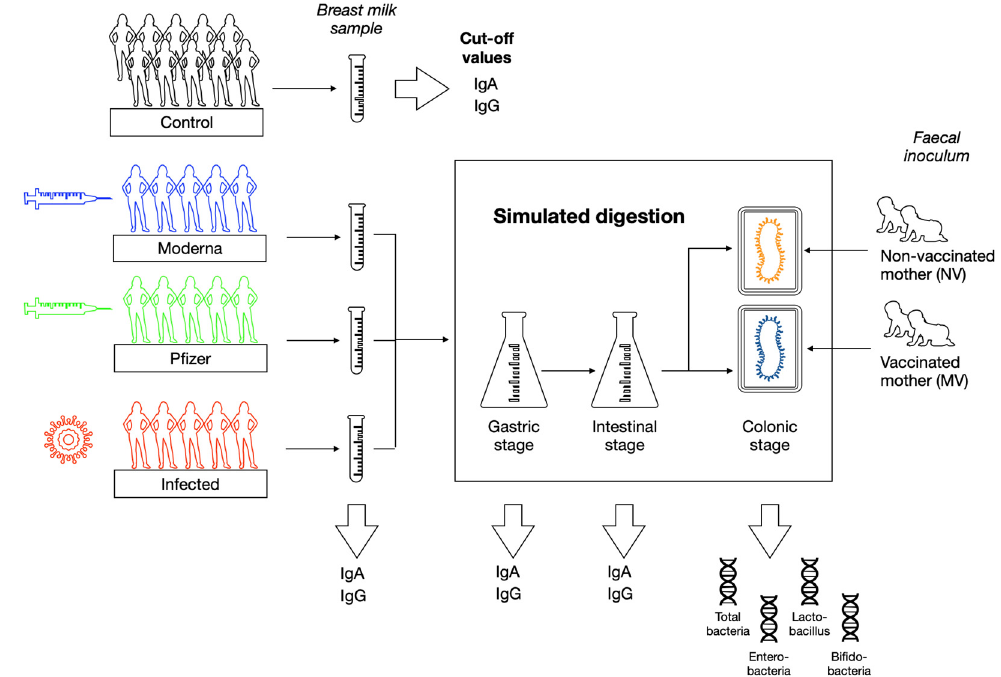
Figure 1. Overview of the study design.